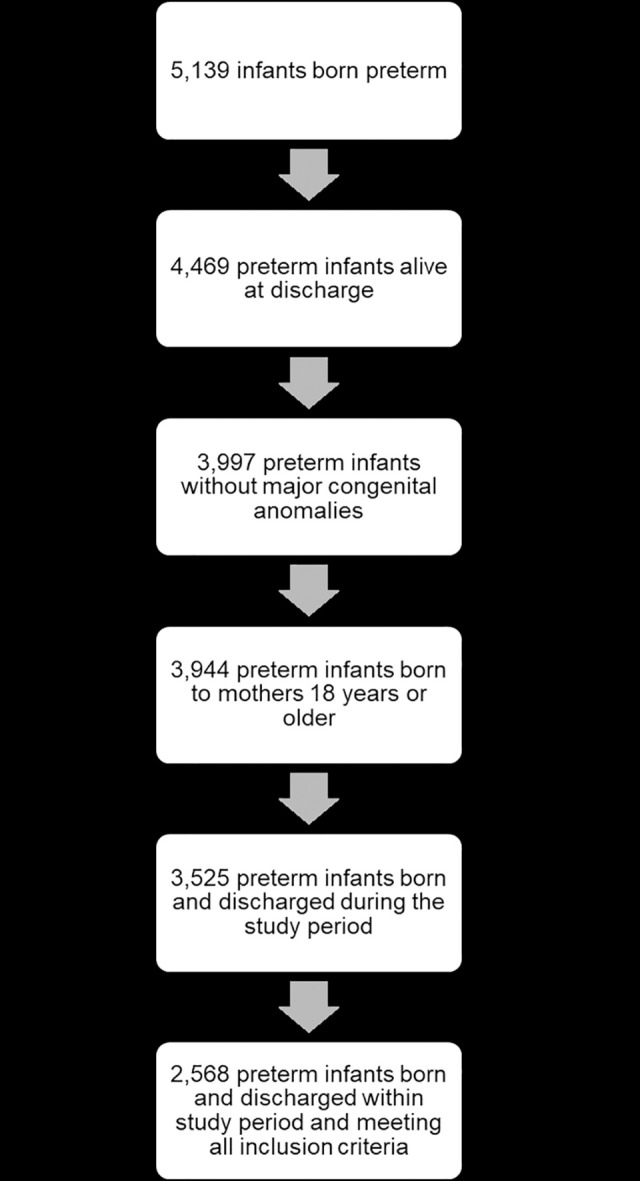
Study population.